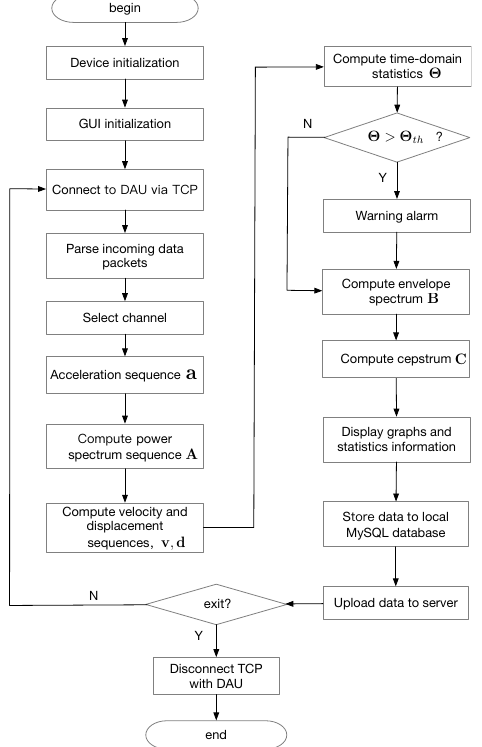
Figure 2. Software flow of the vibration